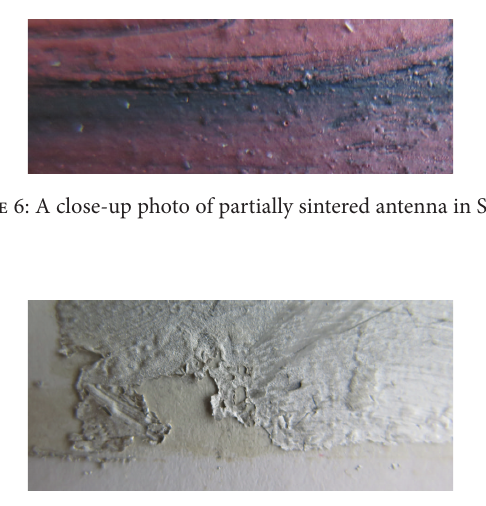
Figure 7: A close-up photo of burned antenna in Sample